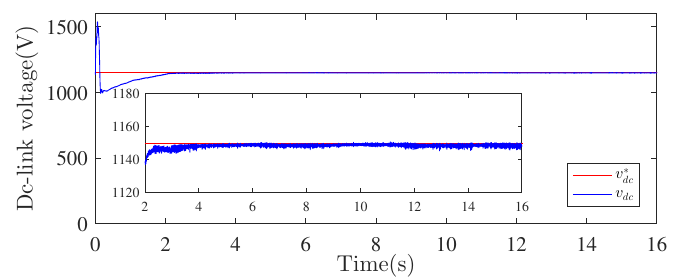
Figure 17. DC-link voltage response under parametric